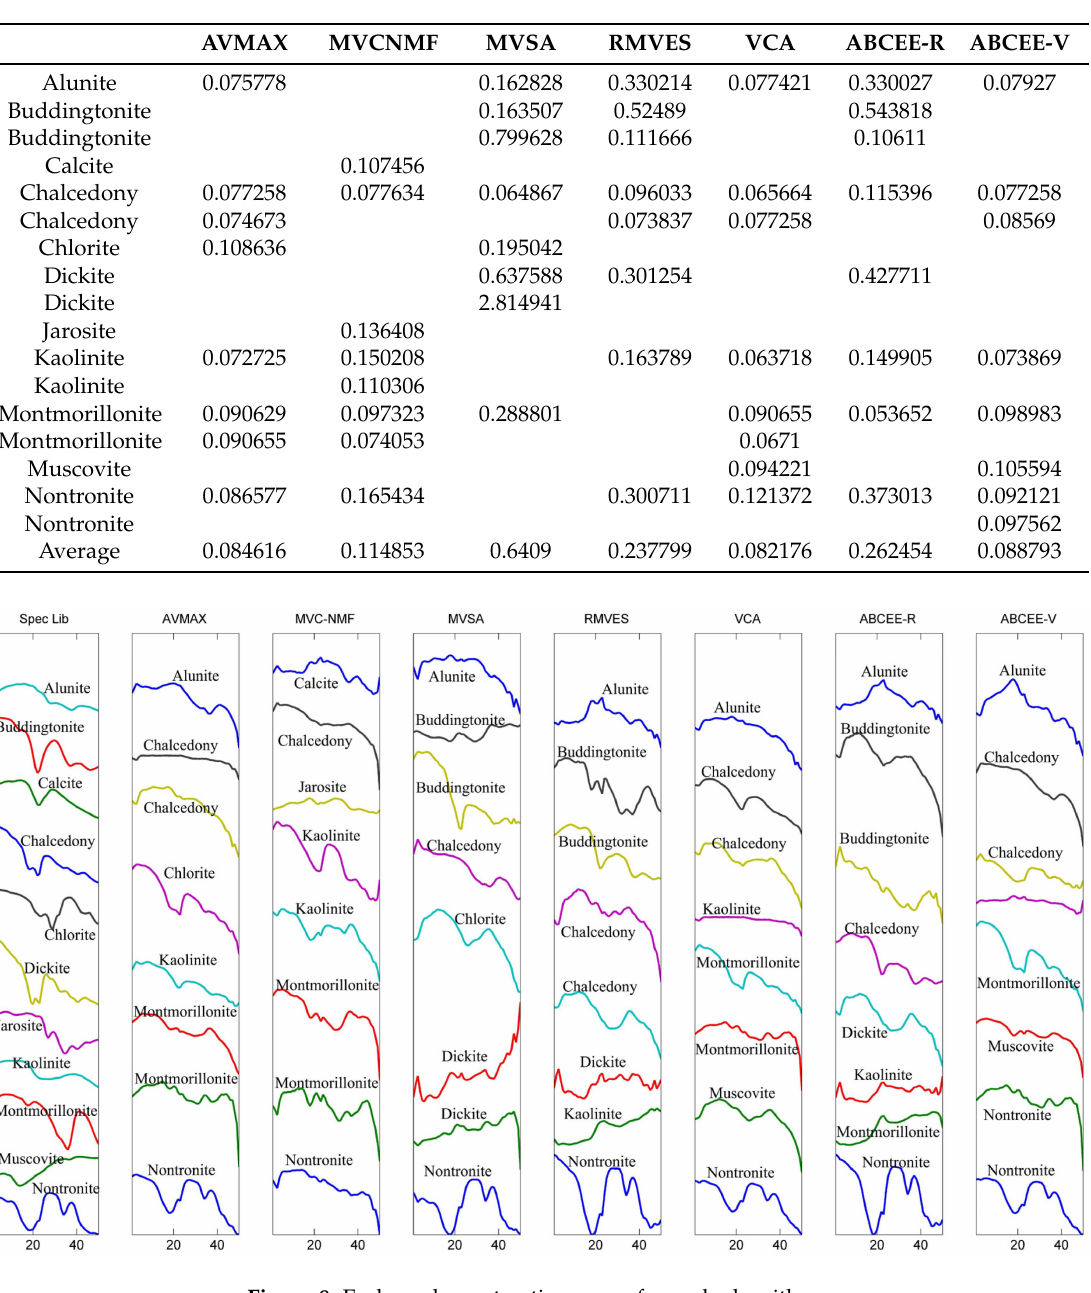
Figure 8. Endmember extraction curve for each